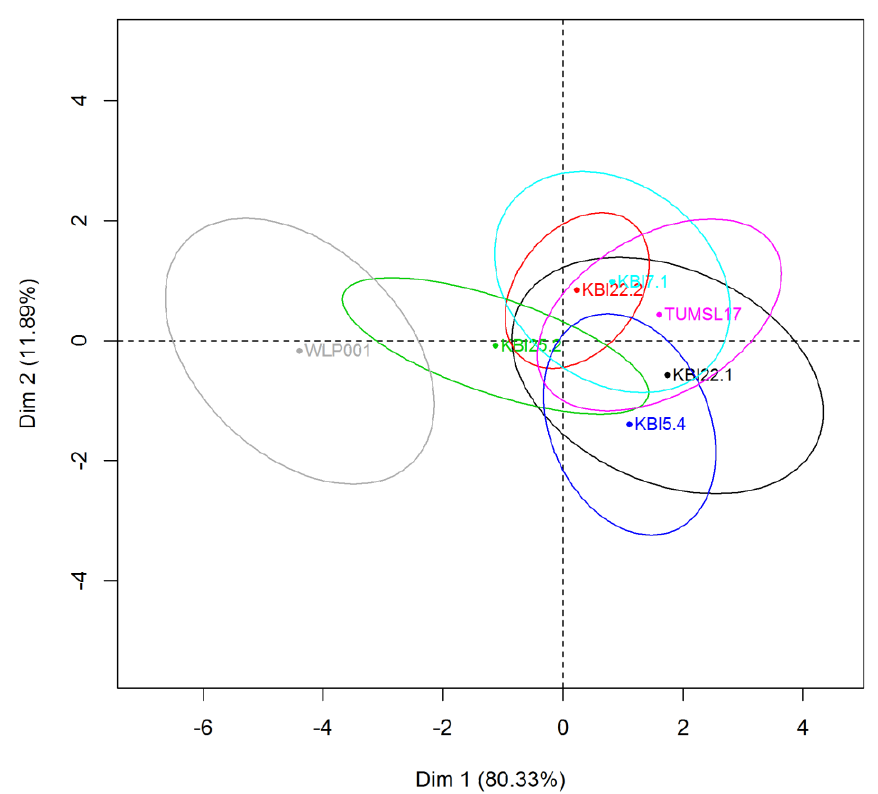
Figure 6. Mean points with confidence ellipses (α = 0.05) of the PCA from the sensory of the final